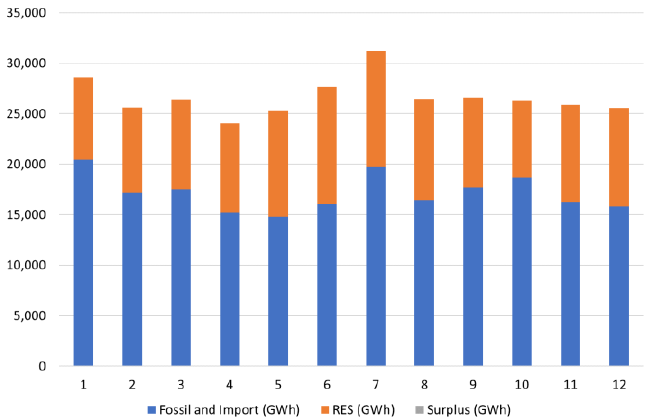
Figure 3. Monthly energy production from renewables, from fossil fuel and imports, and renewable energy surplus.